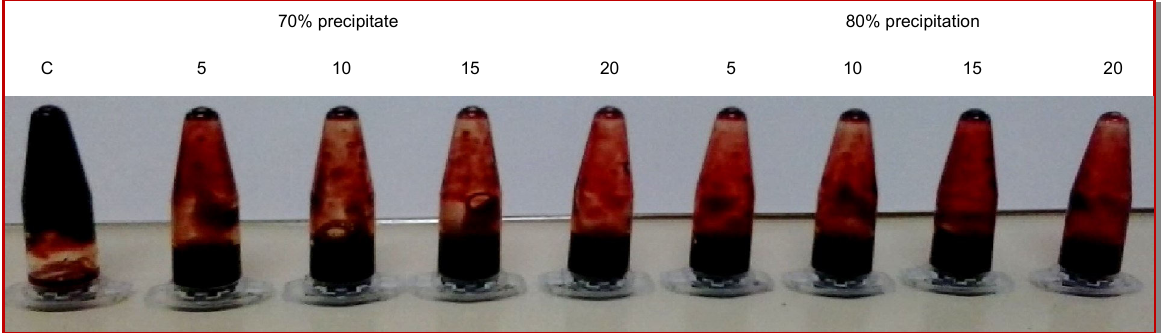
Figure 6: Holmstorm Method for Bacillus sp SFN precipitates in production media with shrimp shell (5, 10, 15, 20 µL)